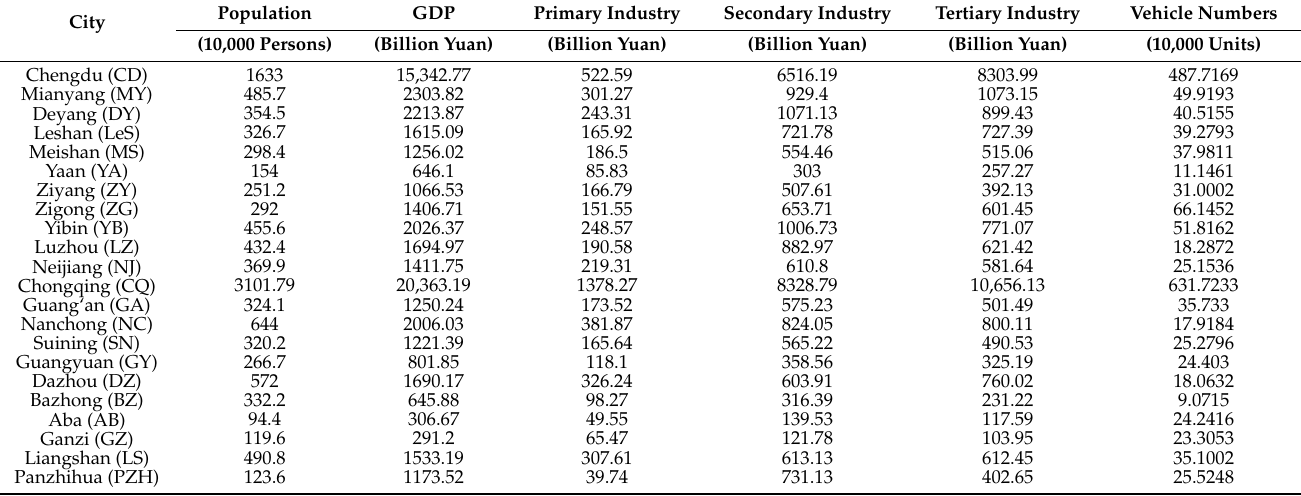
Figure 1. The map of Sichuan Basin and the locations of 22 city stations. Considering the completeness of the data, this study collected the socio-economic Table 1. Urban areas, population, number of vehicles, and GDP of each city in the Sichuan Basin in